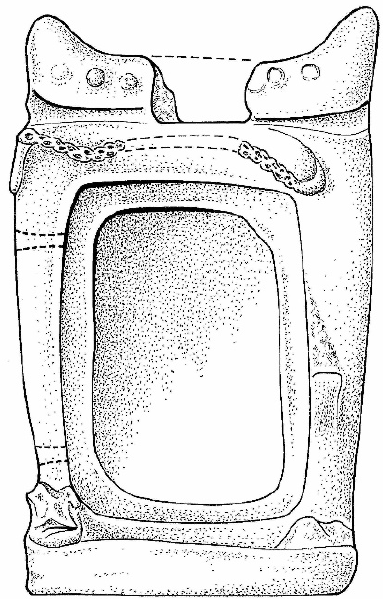
Figure 15. Front view of the Tel Rekhesh shrine model, with the accentuated clay ribbon above the door.